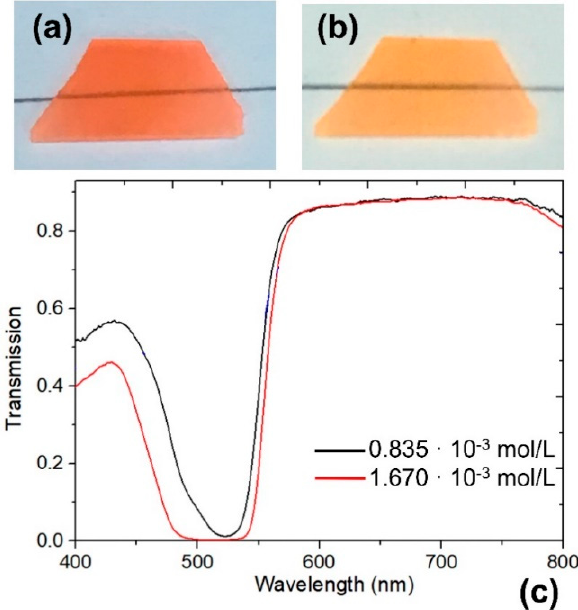
Figure 1. Photos of porous glass (PG) samples impregnated with rhodamine concentrations of ( a ) ~1.670 × 10 − 3 mol/L, and ( b ) ~0.835 × 10 − 3 mol/L. ( c ) Corresponding transmission spectrum in the visible spectral region of 400–800 nm.